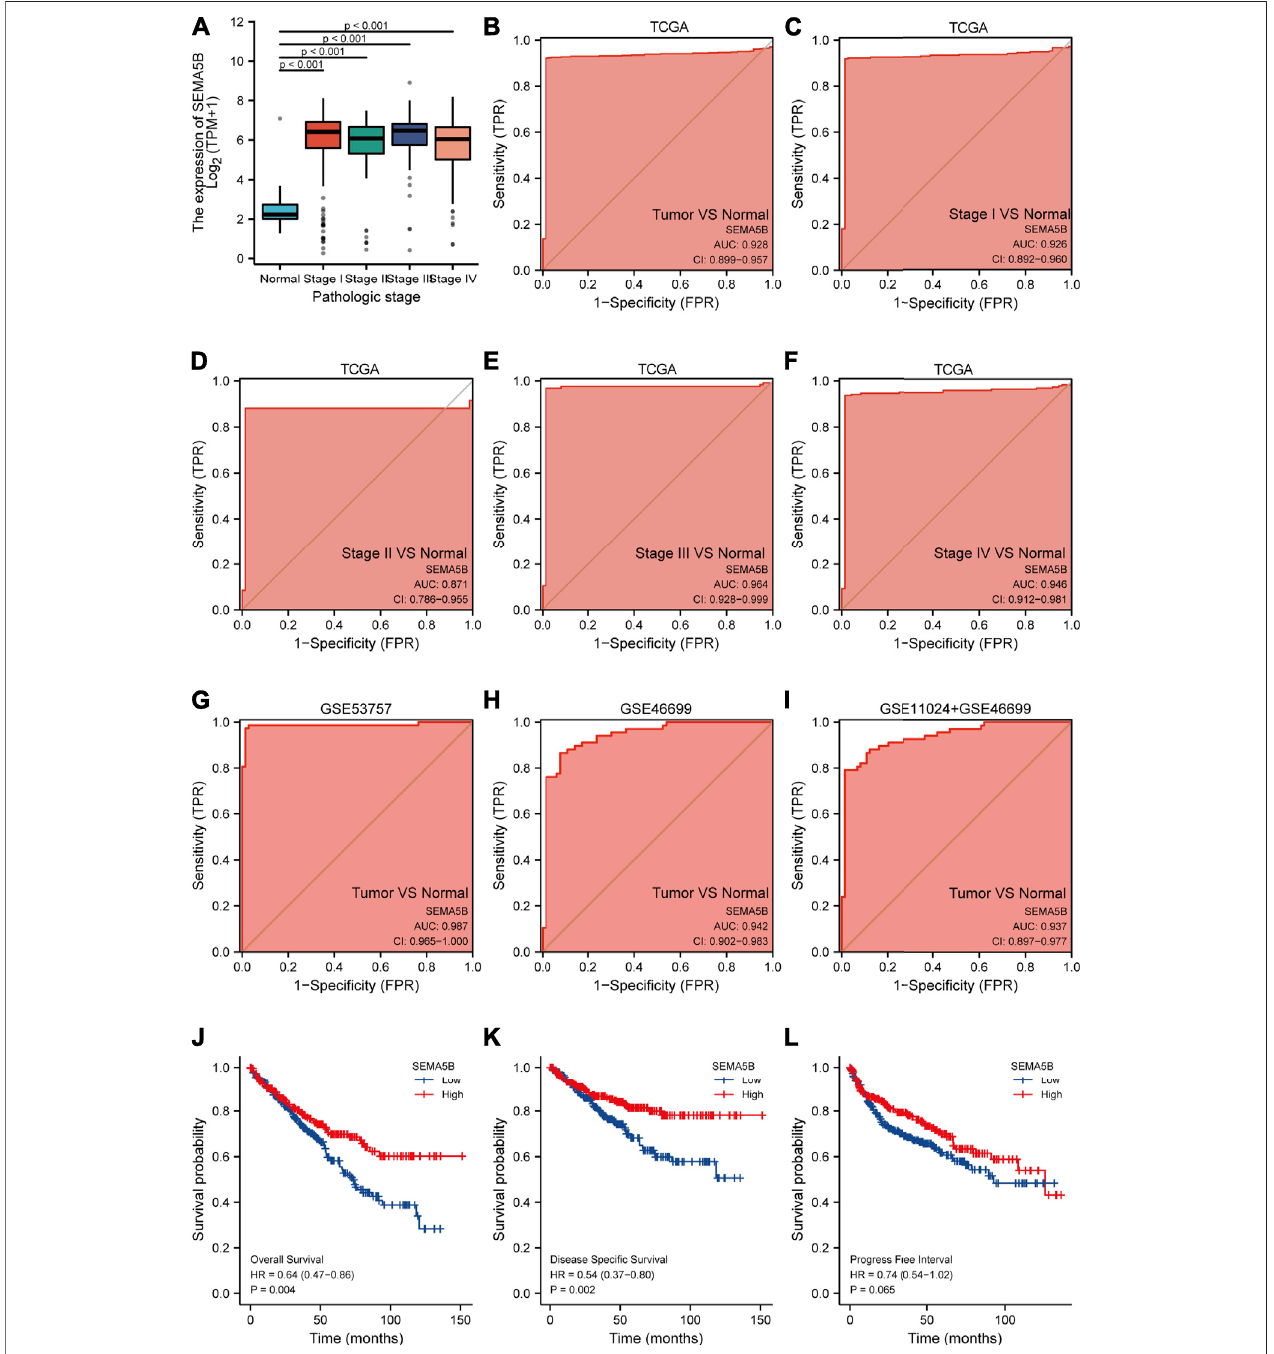
FIGURE 3 | Predictive value of SEMA5B expression for diagnosis and clinical outcomes in KIRC. (A) SEMA5B expression is higher in each pathologic stages of KIRC thannormaltissue based ontheTGCA dataset (all p < 0.001);ROCcurvesofSEMA5B forKIRCcases withoveralltumors (B) ,stageI (C) ,stage II (D) ,stage III (E) , and stage IV in TCGA datasets; ROC curve in validation set of GSE 53757 (G) , GSE46699 (H) , and GSE11024 + GSE46699 (I) for discriminating overall tumors from normal.ShownaretheKaplan – Meieranalysescomparingoverallsurvival (J) ,disease-speci fi csurvival (K) ,andprogression-freeinterval (L) betweenhigh-andlow- SEMA5B expression